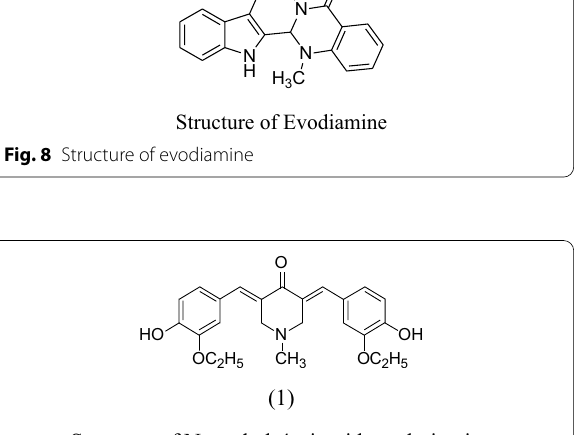
Fig. 10 Structure of a piperidine derivative